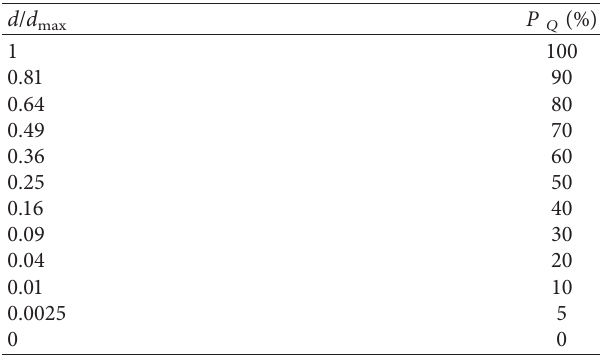
Table 2: Percentage by mass of different particle sizes by applying quadratic scaling-down technique (equation (4)).